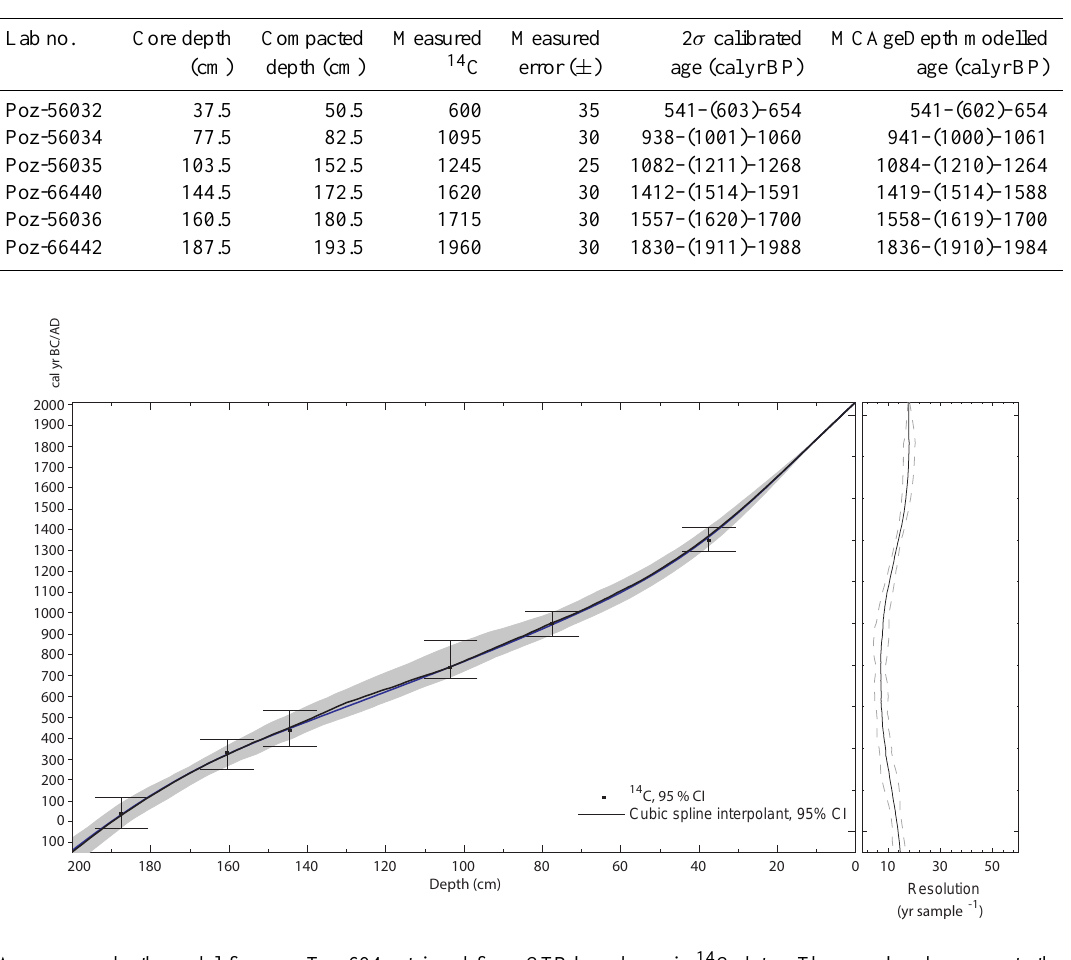
Figure 2. Age-versus-depth model for core Tuz 694 retrieved from CTP based on six 14 C dates. The grey band represents the modelled range of dates and the black line the 50th percentile of all